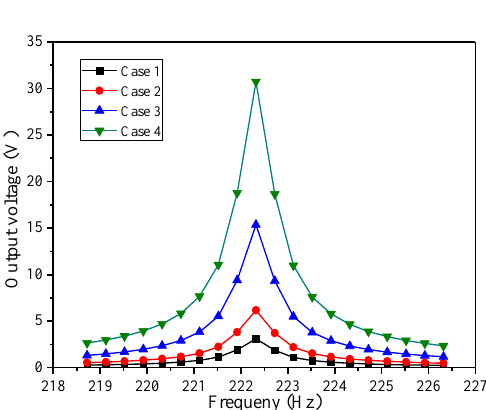
Figure 4. Harmonic curves.